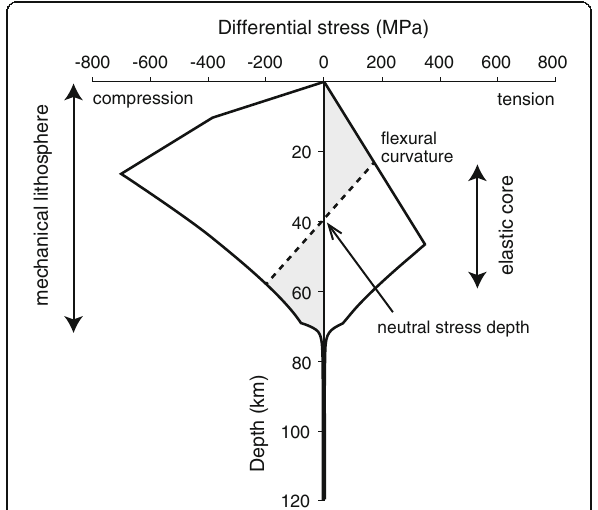
Fig. 2 Rheological model of the Martian lithosphere under wet conditions. A constant thermal gradient of 8 K/km and a strain-rate of 10 − 19 s − 1 were used in the calculations. Positive and negative differential stresses correspond to tension and compression, respectively. The bending moment is calculated via a balance between tensional and compressional forces within the flexed lithosphere (shaded area). Elastic thickness was calculated from the integrated bending moment following the procedure of McNutt (1984). Mechanical thickness is the rheological boundary at based of lithosphere, which is calculated from the depth where stress threshold is assumed to be 50 MPa (McNutt 1984)